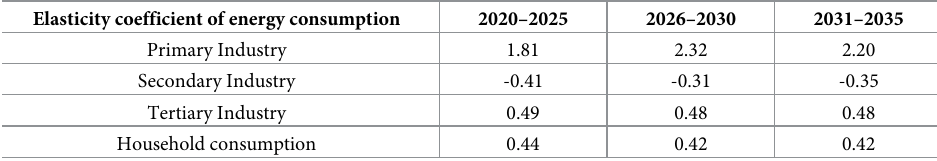
Table 4. Elasticity coefficient of energy consumption in different industries and stages.